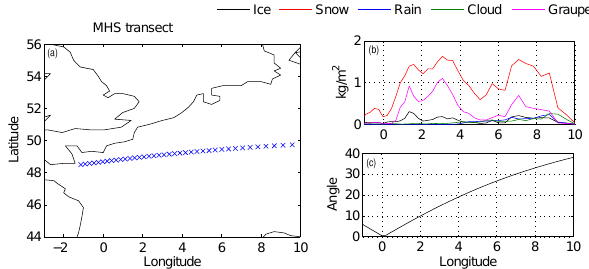
Figure 5. Selected transect of the case study: (a) the location of the transect; (b) the integrated content of the different Meso-NH hydrometeors along this transect; and (c) the incidence angle of the MHS observations along the transect.